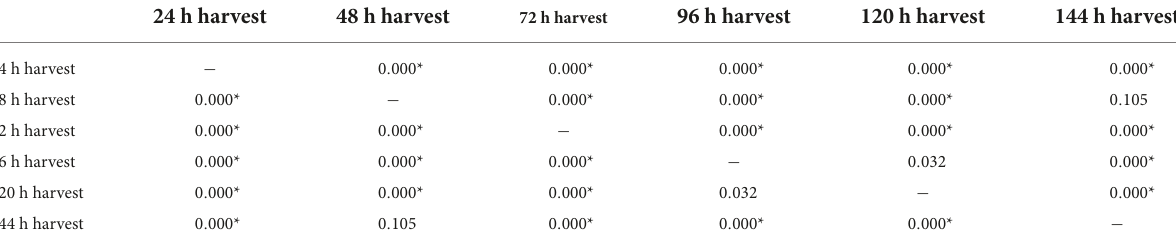
TABLE 13 Pairwise comparison of the harvests for SOD by Scheffe post hoc